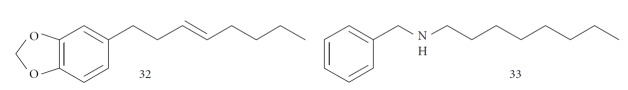
Chemical structures of 5-[(3E)-oct-3-en-1-il]-1,3-benzodioxole (32) and LINS03011 (33).